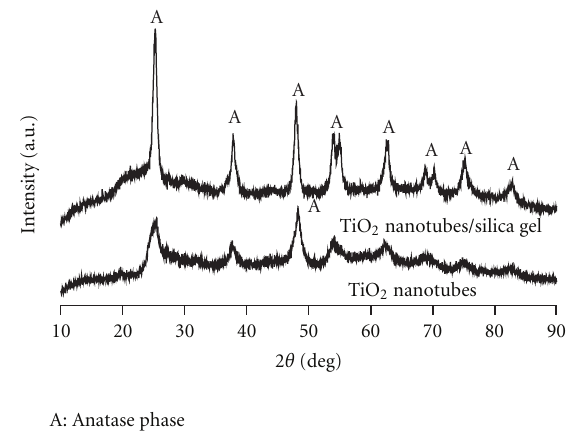
Figure 1: XRD patterns of TiO 2 nanotubes/silica gel and TiO 2